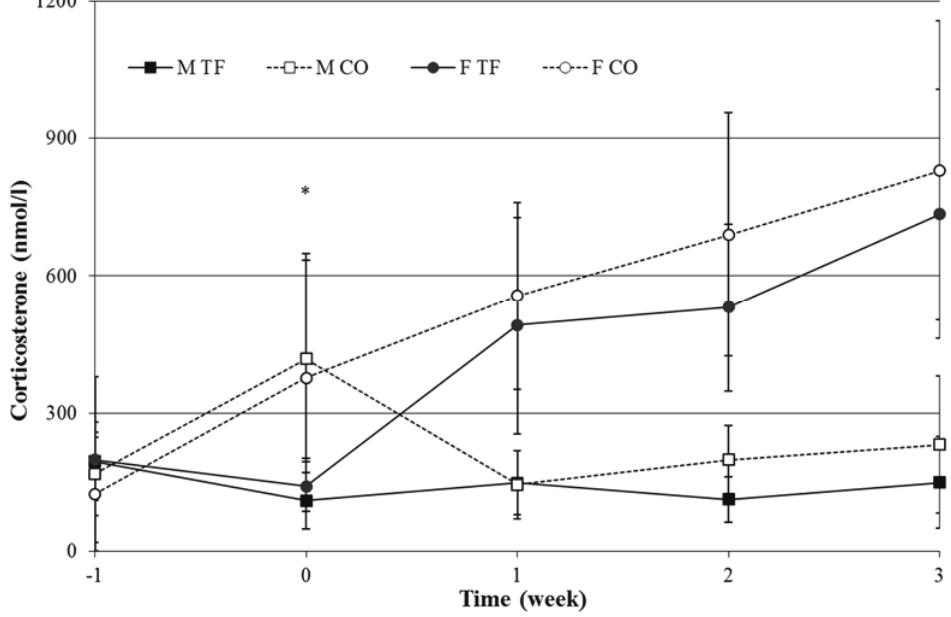
Figure 4. Plasma corticosterone levels (nmol/L) in male (squares) and female (circles), transferred (black symbols-solid line) and control (white symbols-dotted line) rats, one week before, on day of transfer and one, two and three weeks after transfer ( n = 8). * indicates significant difference between TF and CO.